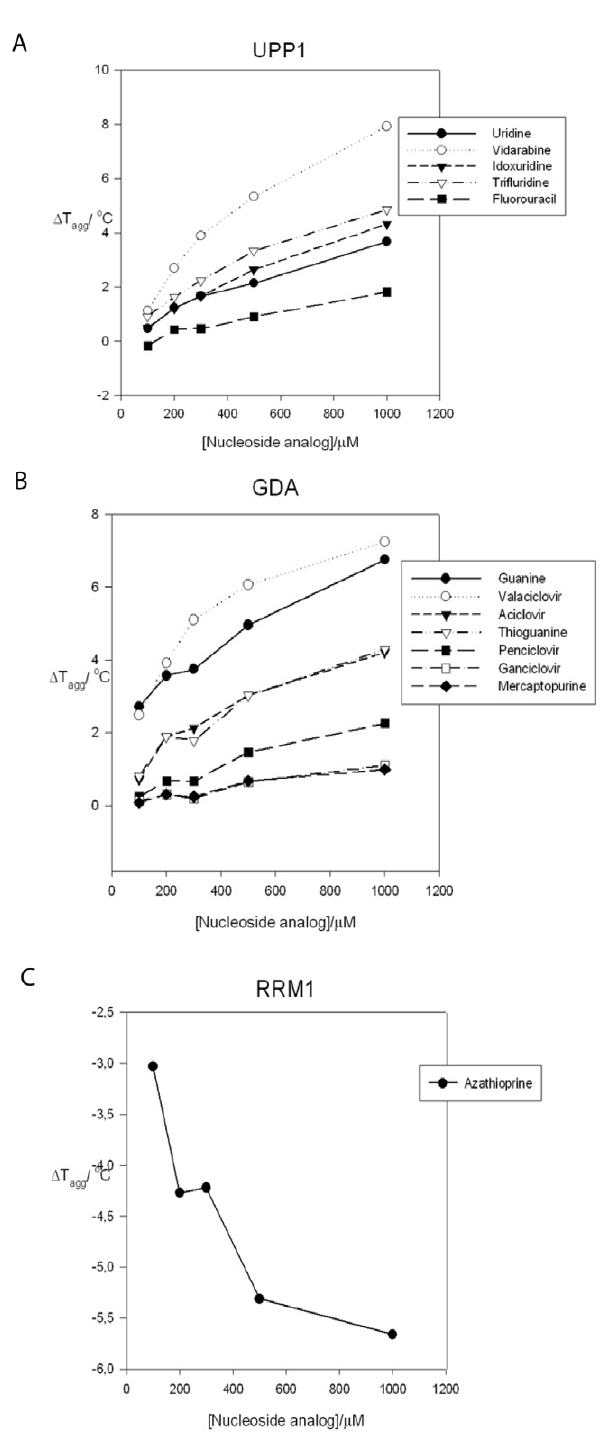
Figure 2. Concentration-dependent stabilization of UPP1 (A) in the presence of uridine, vidarabine, idoxuridine, trifluridine and fluorouracil; GDA (B) in the presence of guanine, valaciclovir, aciclovir, thioguanine, penciclovir, ganciclovir and mercaptopurine; and concentration dependent destabili- zation of RRM1 (C) in the presence of azathioprine.